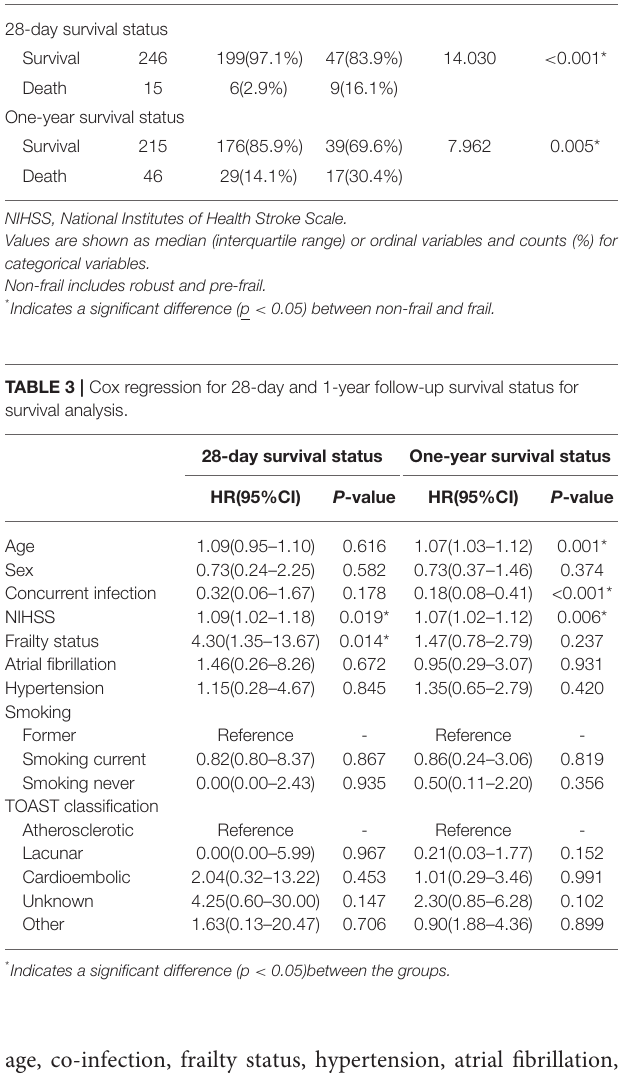
TABLE 4 | Demographics and clinical characteristics of the participants for functional recovery analysis. Robust ( n = 85)